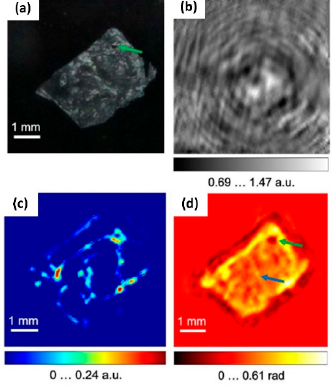
Figure 15. The CW THz in-line holography of human liver cancer sample: ( a ) Photo of the liver cancer sample; ( b ) In-line THz hologram; ( c ) The reconstructed amplitude and ( d ) phase images. The phase image contains more structural information. The tissue fibrosis arrows point to a sign of cirrhosis that was untreated and developed into liver cancer. Adapted from [93] under the terms of the Creative Commons Attribution 4.0 License.